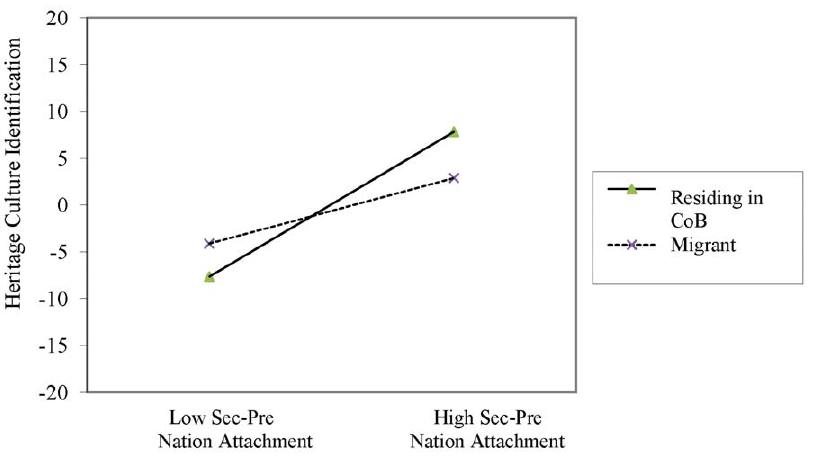
Figure 2. Interaction between resident status and secure-preoccupied nation attachment in predicting heritage culture identification levels in Study